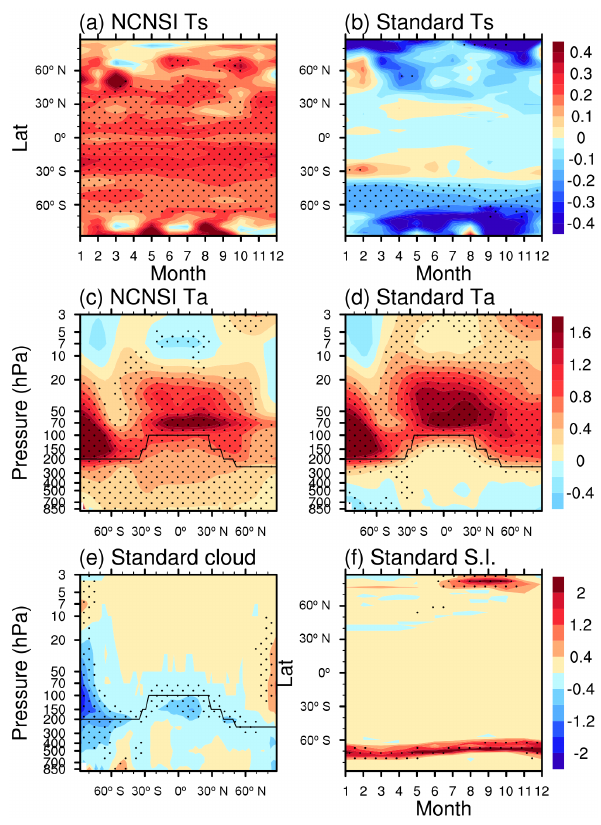
Figure 2. Responses to SOR of zonal mean surface temperature, an- nual and zonal mean air temperature, annual and zonal mean cloud fraction, and zonal mean sea-ice fraction. Latitude–month distribu- tion of surface temperature in the (a) NCNSI, and (b) Standard ex- periment. Vertical cross section of air temperature in the (c) NCNSI, and (d) Standard experiment. (e) Vertical cross section of cloud fraction, and (f) latitude–month distribution of sea-ice fraction in the Standard experiment. In (a, b) , the color interval is 0.05K. In (c, d) , the color interval is 0.2K. In (e – f) , the color interval is 0.4%. Regions with dots are the places where differences have statisti- cal significant levels higher than the 95% confidence level (student t test values are greater than 2.0). The black line in (c – e) indicates the tropopause of